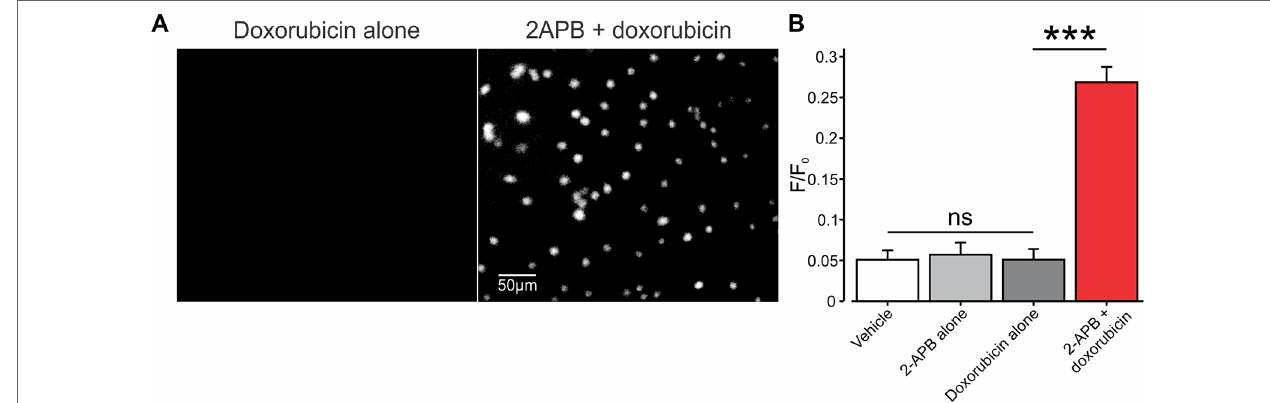
FIGURE 2 | Co-application of 2-APB with doxorubicin leads to facilitated entry of doxorubicin into mouse BNL1 ME cells. (A) Representative epifluorescent images of cultured BNL1 ME cells, 5 min after application 1 µM doxorubicin alone ( left ) and co-application of 200 μM 2-APB with 1 µM doxorubicin ( right ). Note that doxorubicin-based fluorescence ( see Methods ) was detected only when co-applied with 2-APB. (B) Bar graph depicting means ± SEM of changes in intensity of intracellular fluorescence following application of vehicle, 2-APB alone, doxorubicin alone, or doxorubicin together with 2-APB at the indicated concentrations. The values for vehicle and 2-APB alone were measured 30 min after application. 2-APB was then washed out for 30 min, and the values for doxorubicin alone or doxorubicin together with 2-APB were measured after 60 min each. Note that doxorubicin-based intracellular fluorescence was above the noise levels (0.05 F/F 0 ) only after the co-application of doxorubicin with 2-APB. ***p < 0.001, compared to doxorubicin alone, paired t -test, ns, not significant, n = 60 cells, three